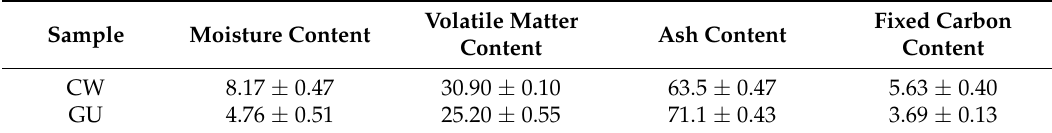
Table 1. Results of dried sludge proximate analysis for each water treatment facility.